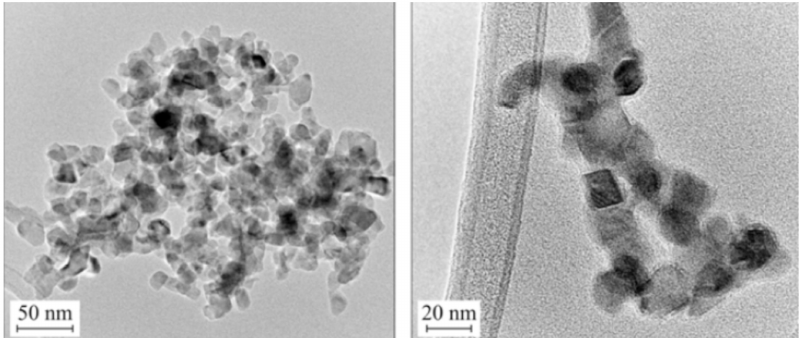
Figure 10. HRTEM images of the oxide system TiZr6 calcined at 700 ◦ C (created based on [189] with permission from